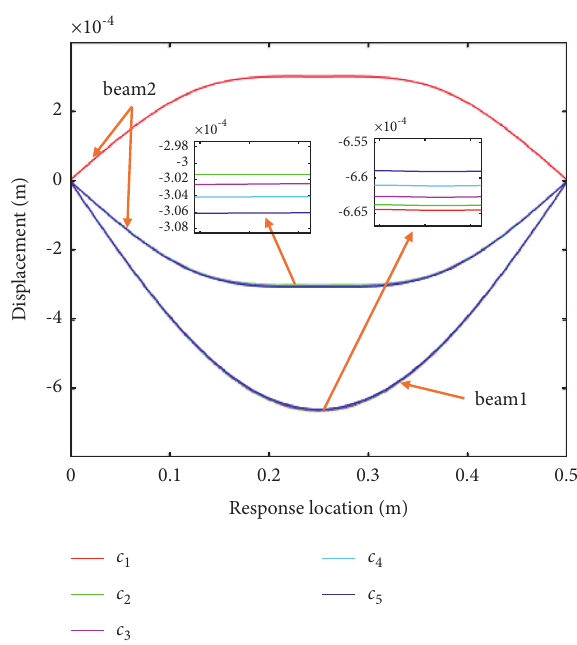
Figure 22: Vibration shape of the composite system under dif- ferent